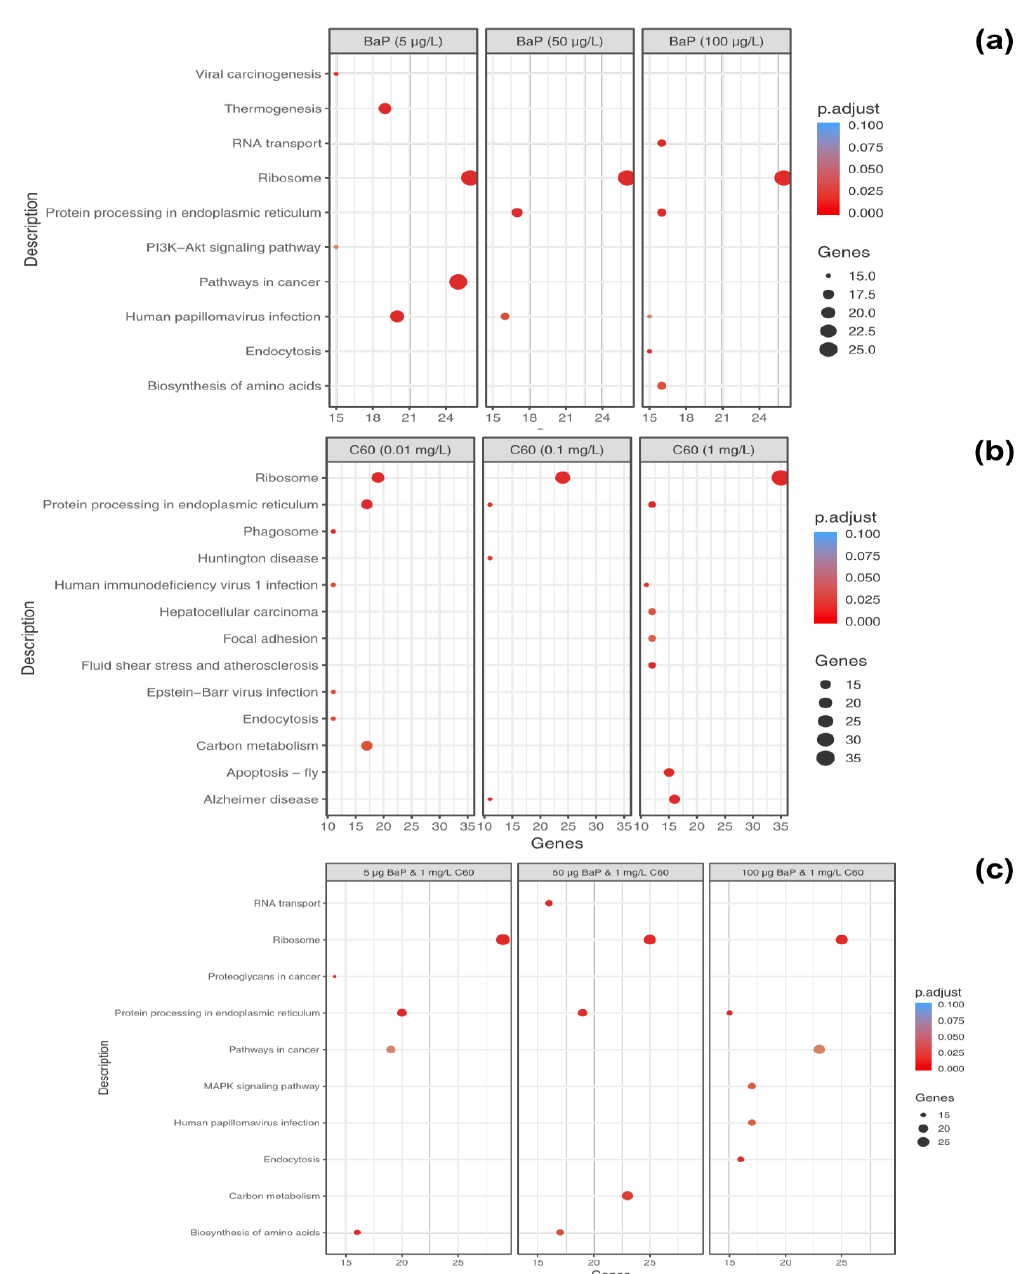
Figure 7. Dotplot of enriched KEGG pathways for differentially expressed genes (DEGs) ( p < 0.05) that were common between concentrations of B[a]P ( a ), C 60 ( b ) and a mixture of 5, 50 and 100 µg/L with 1 mg/L C 60 ( c ). Along the x -axis, genes represent the number of genes identified as enriched in this particular pathway. The size and colour of each dot represents the gene number and adjustment p based on FDR